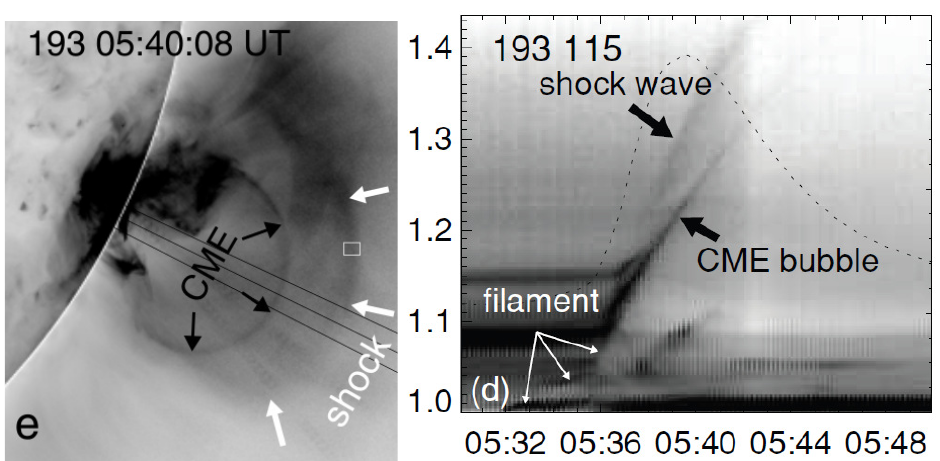
Figure 38: The coronal wave of 2010 Jun 13 observed at ultra-high cadence in EUV with SDO/AIA. Left : 193 ˚A base image (with reversed color table) showing an expanding CME bubble ( CME ), which is embedded in a dome-shaped coronal wave ( shock ). Right : Distance-time intensity stack plot at 193 ˚A (reversed color table) along the radial direction. The coronal wave is formed closely ahead of the expanding bubble and continuously increases its offset distance. Images reproduced with permission from Ma et al. (2011), copyright by